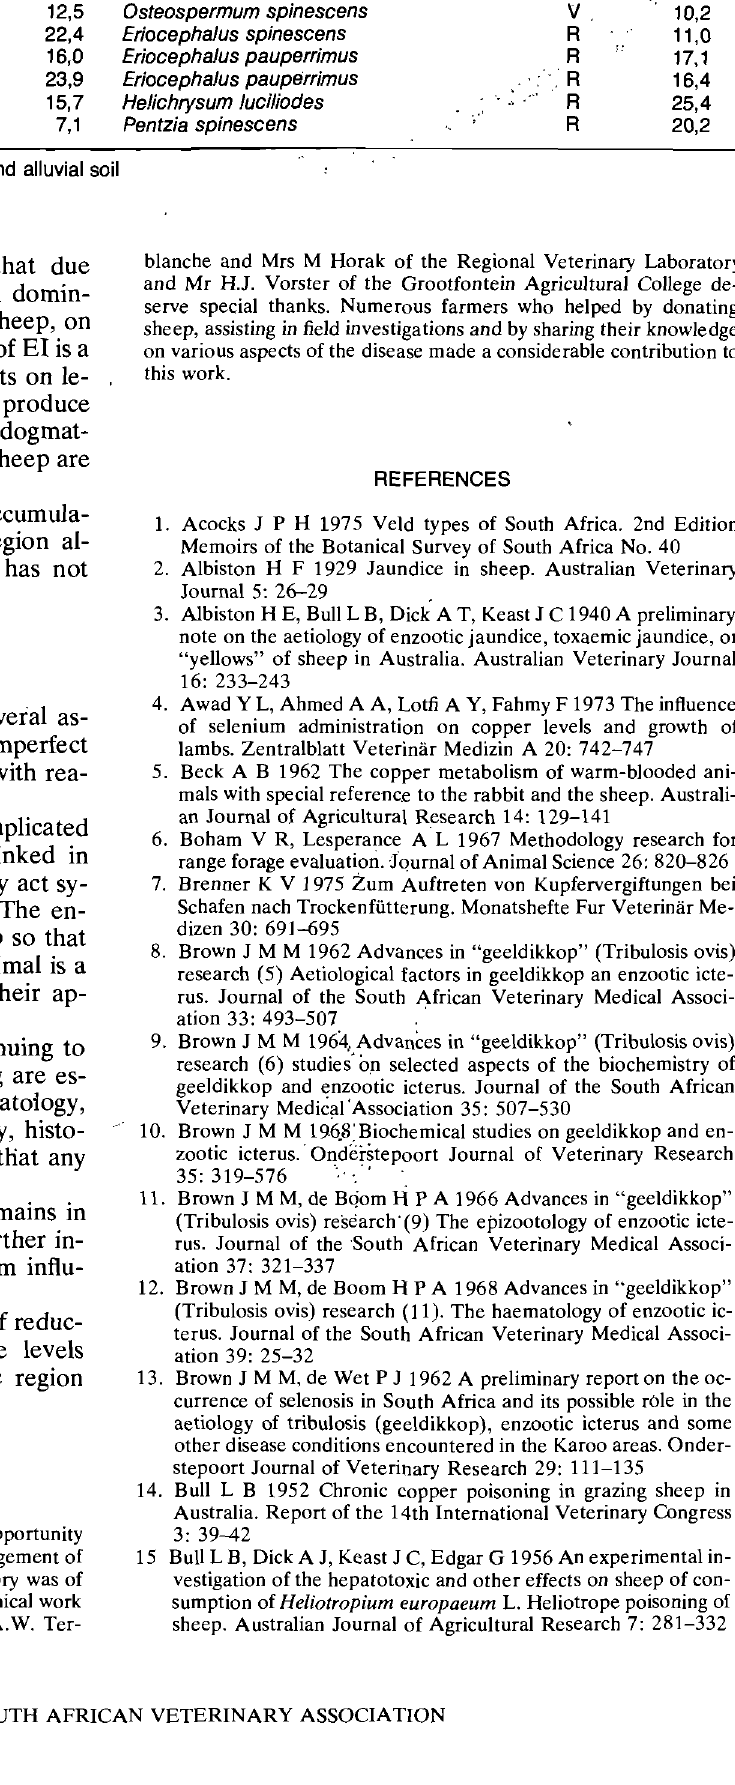
Table 5: COPPER LEVELS IN /-Lg/g (DRY MASS):IN VARIOUS BUSHES IN TWO CAMPS OF A FARM WHERE ENZOOTIC ICTERUS Plant (Camp